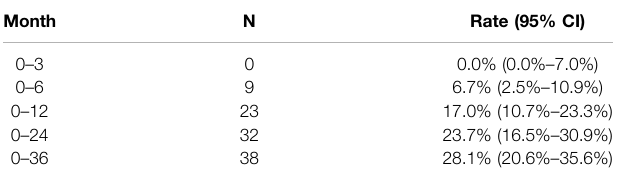
TABLE 2 | Rate of ischemic stroke recurrence (N =